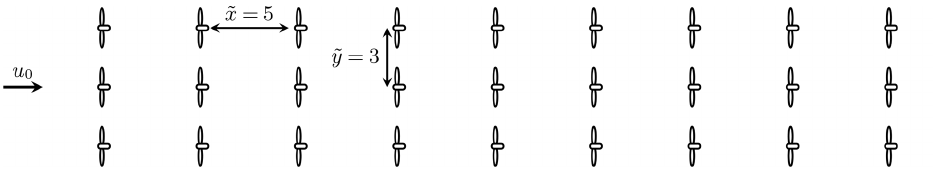
Figure 2. Schematic view of the simulated wind farm. Table 1. Coefficients of the super-Gaussian wake model. a